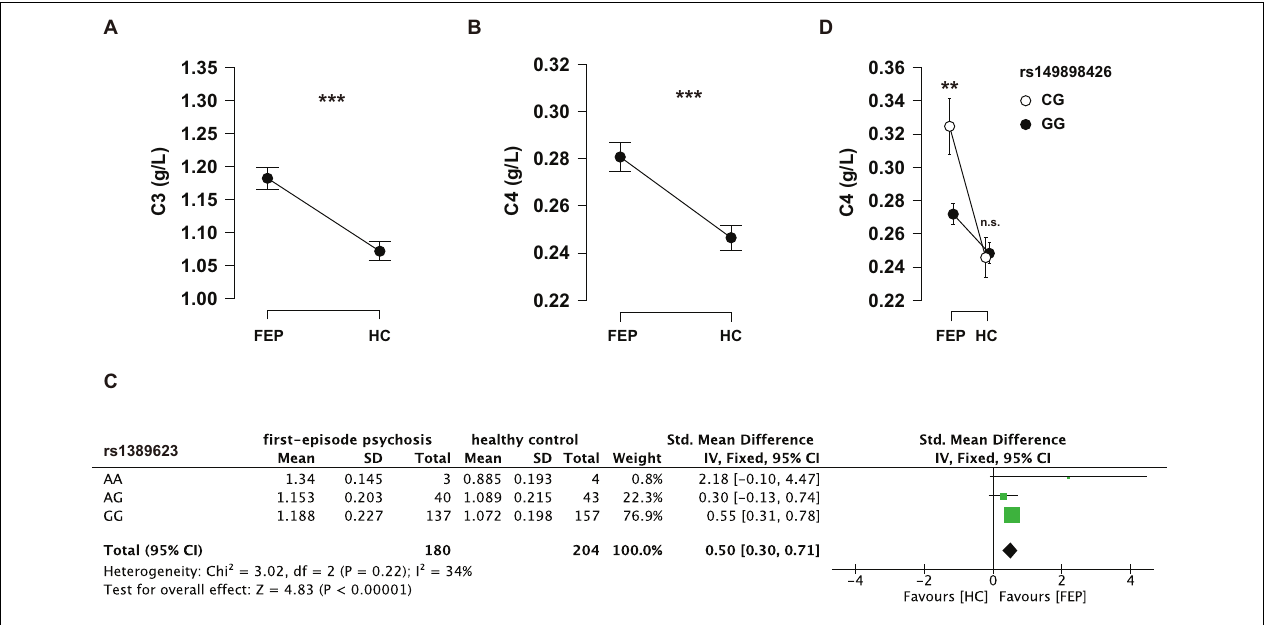
FIGURE 2 | (A) Serum C3 protein levels between FEP and HC. (B) Serum C4 protein levels between FEP and HC. Data were analyzed by Student’s t -tests. (C) Serum C4 levels among the genotypes of rs149898426 (CG and GG) in FEP and HC receptively. Data were analyzed by a two-way ANOVA with Tukey post hoc tests. Data shown in the figure represent mean ± SEM. ** P < 0.01; *** P < 0.001; n.s.: non-significant. (D) A meta-analysis of the genotypes of rs1389623 on serum C3 levels.